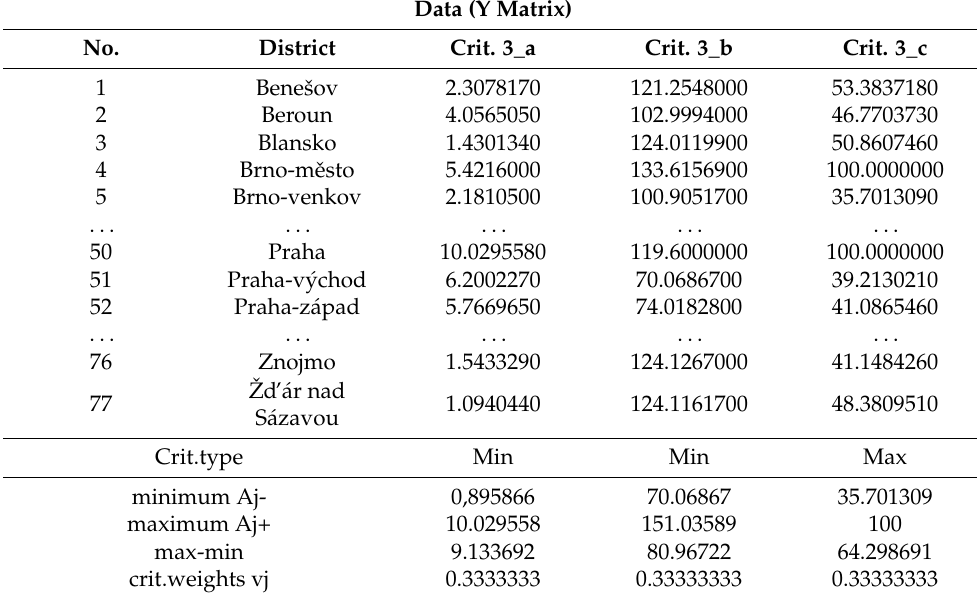
Table A2. Data for 3. area, selected districts.